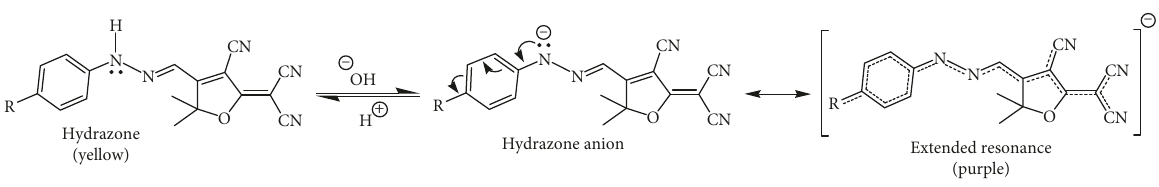
Scheme 3: Suggested pH sensing